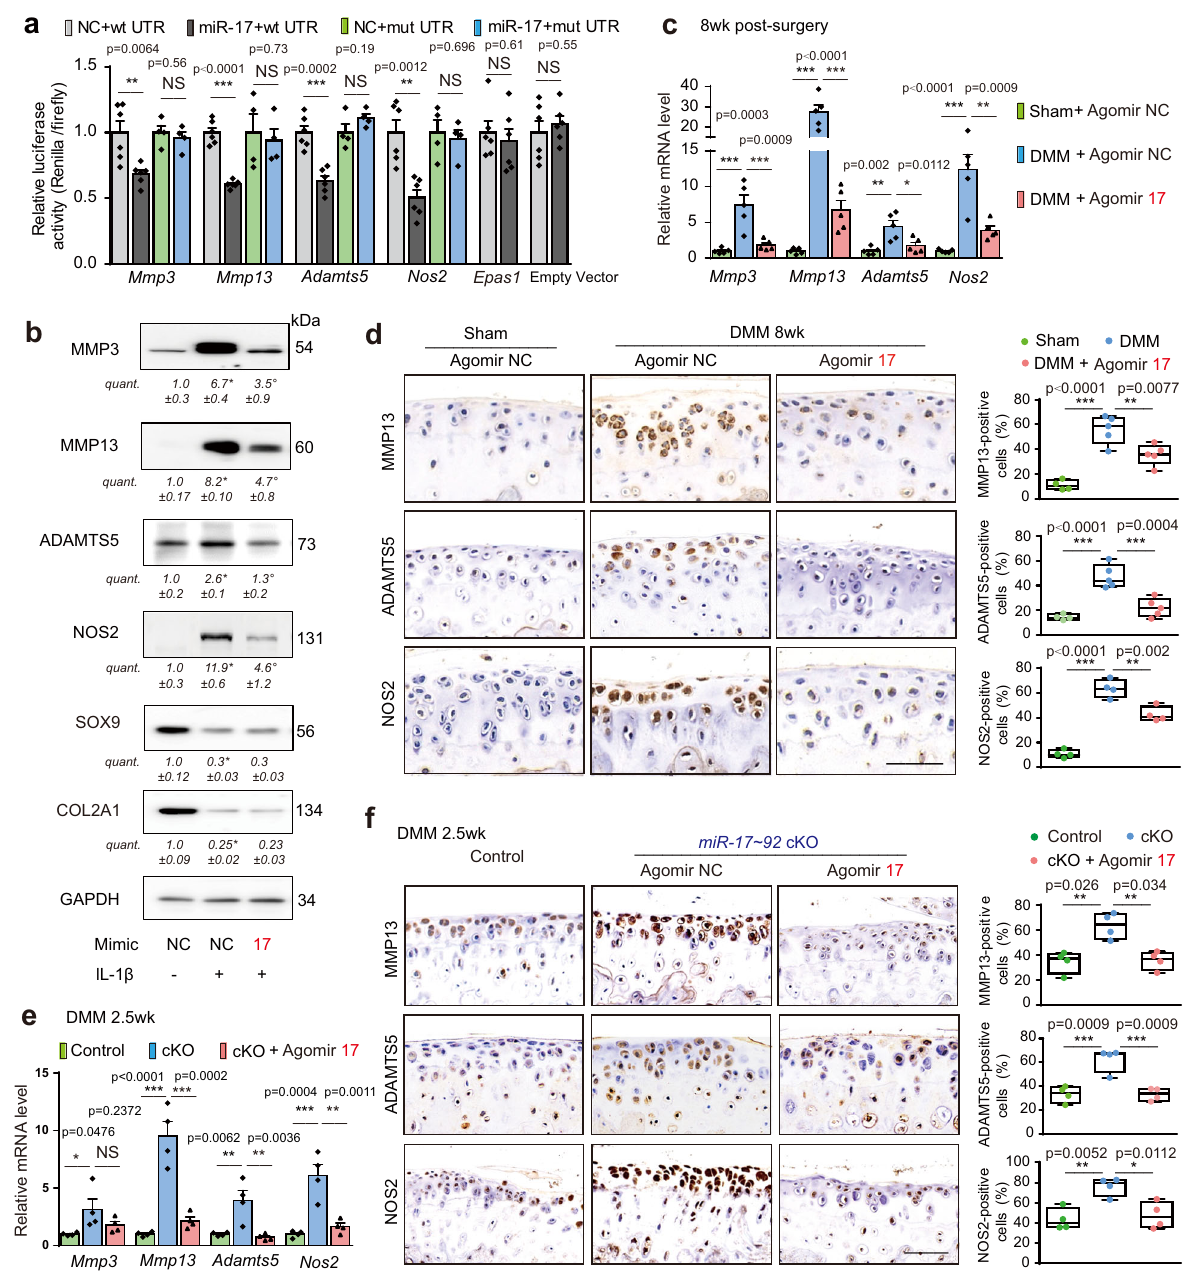
GDF-5 upregulated endogenous miR-17 to protect against OA . To explore whether similar levels of protection against OA could be achieved through upregulation of endogenous miR-17, we selected GDF-5 as an inducer for miR-17. In cultured mouse articular chondrocytes, exogenous GDF-5 induced expression of miR-17 under IL-1 β stimulation (Supplementary Fig. 6a).